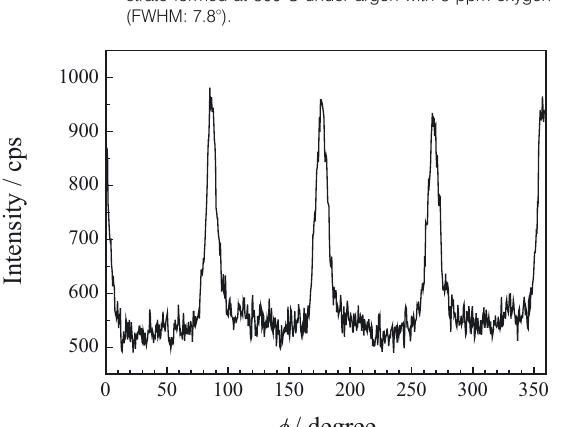
Figure 3. f scan of the (111) peak of NiO on a textured Ni sub- strate formed at 800°C under argon with 3 ppm oxygen (FWHM: